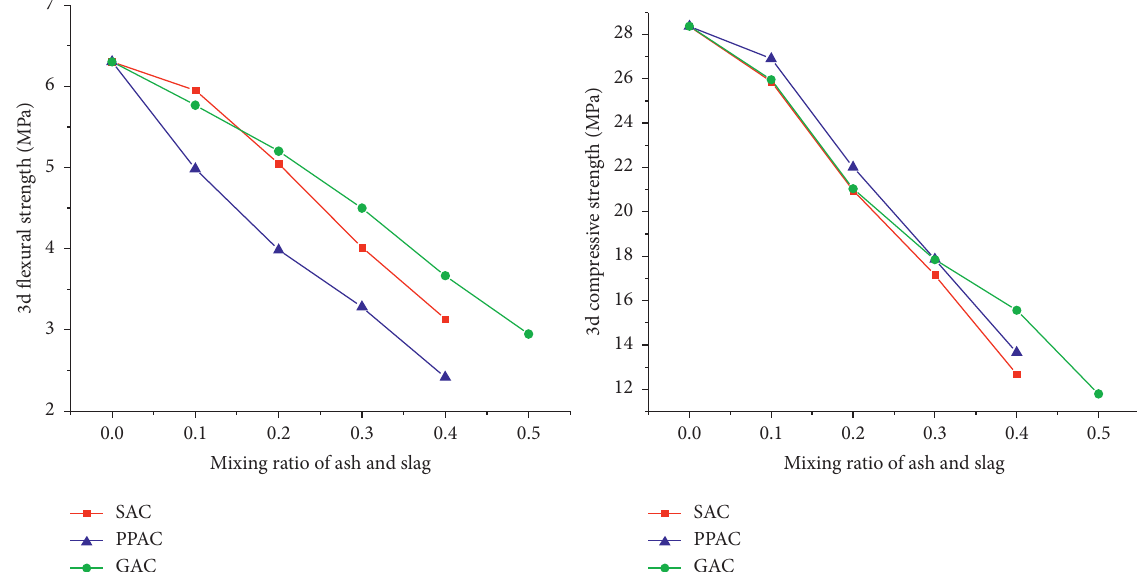
Figure 11: 3-day strength comparison diagram of mortar with different dosage of oil shale waste residue powder.